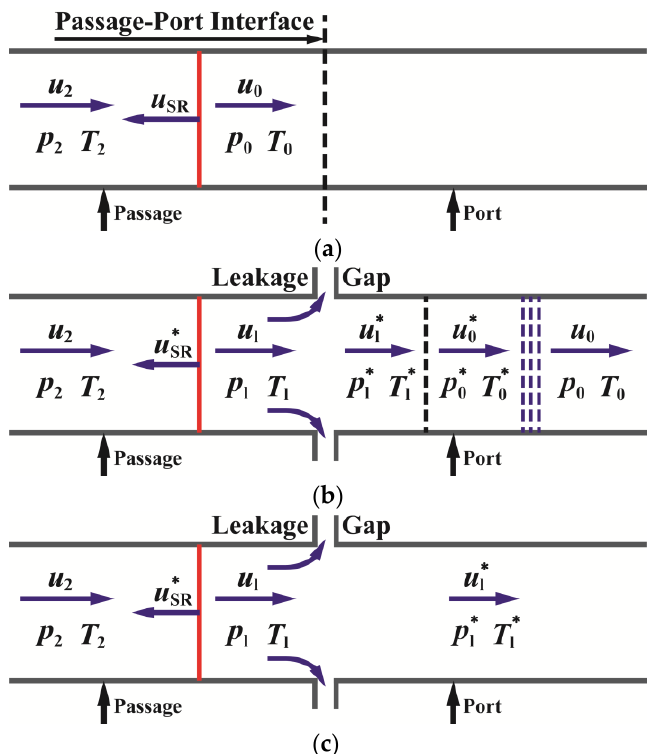
Figure 5. ( a ) Flow parameter matching relations without leakage of the leakage attributed nonsteady shock wave loss model; ( b ) flow parameter matching process with the leakage of the model; and ( c ) flow parameter matching relations at the stable state with the leakage of the model.